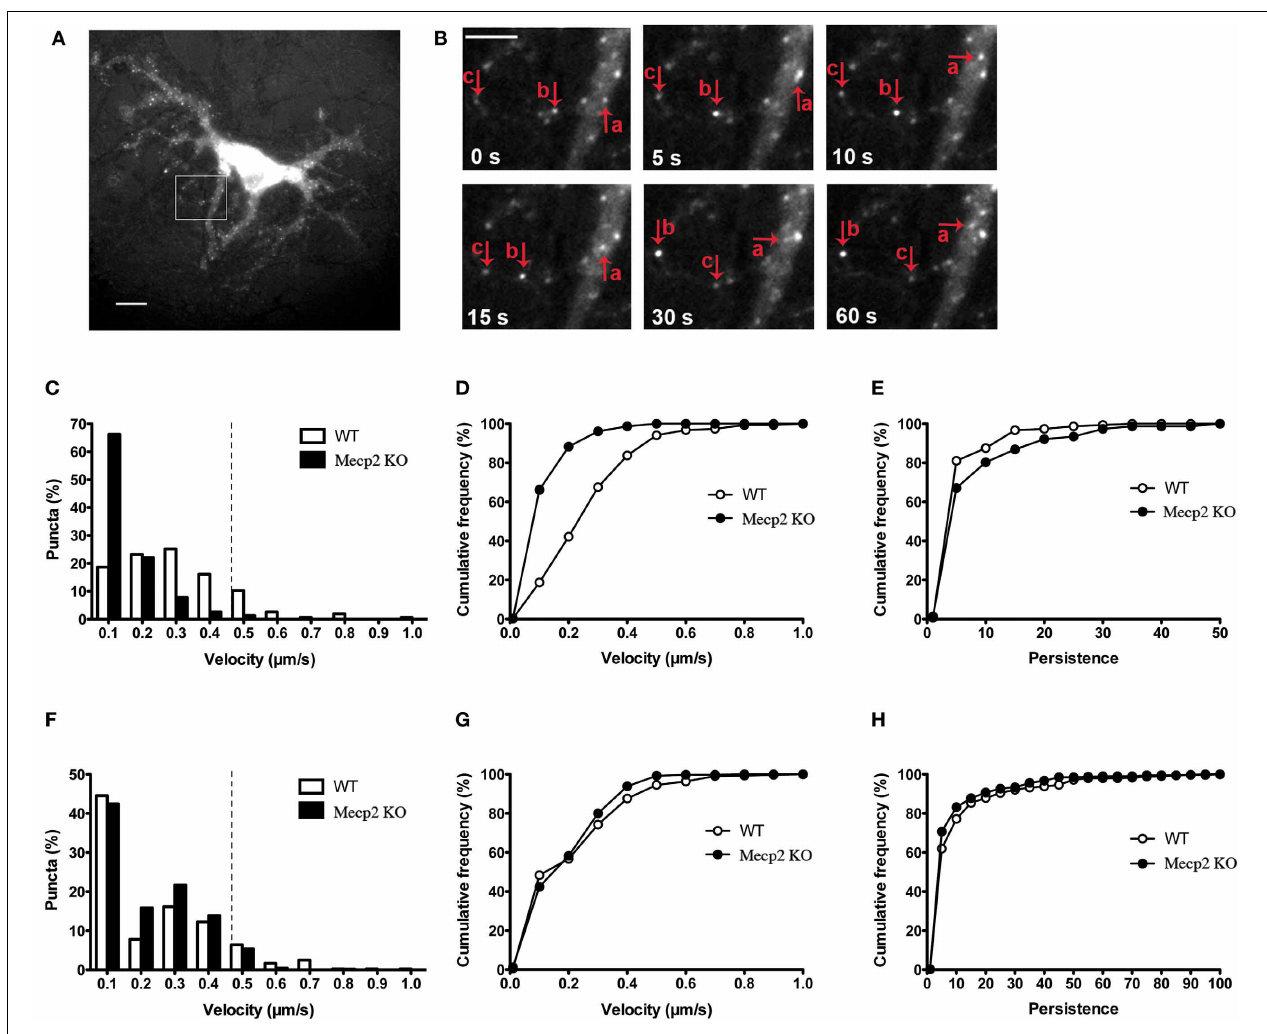
FIGURE 1 | BDNF-YFP trafficking is impaired in Mecp2 knockout neurons. (A) Representative example of a cultured pyramidal neuron expressing BDNF-YFP; scale bar = 10 μ m. The white square is enlarged in (B) . (B) Movement of BDNF-YFP punta (a, b, and c); scale bar = 5 μ m. Each image was taken at the time point indicated at bottom left. (C) Distributions of velocities of BDNF-YFP puncta in wildtype and Mecp2 knockout neurons.